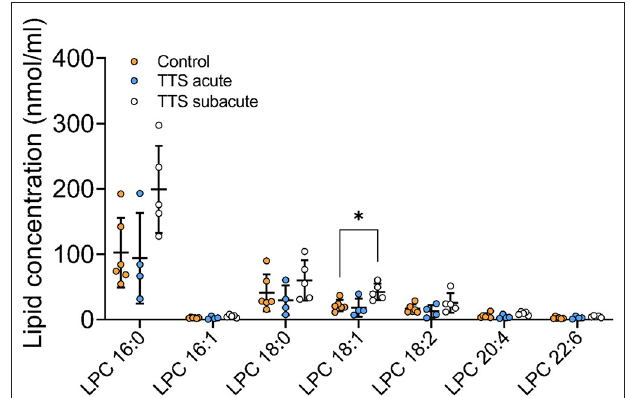
FIGURE 4 | Composition of individual LPC lipid species in the acute TTS, subacute TTS, and control groups. Values are represented as nmol/ml. Values are mean ± SD, P -value: * P < 0.05. Where significance is not mentioned, values are considered as being not significant. LPC, Lysophosphatidylcholine; TTS, Takotsubo